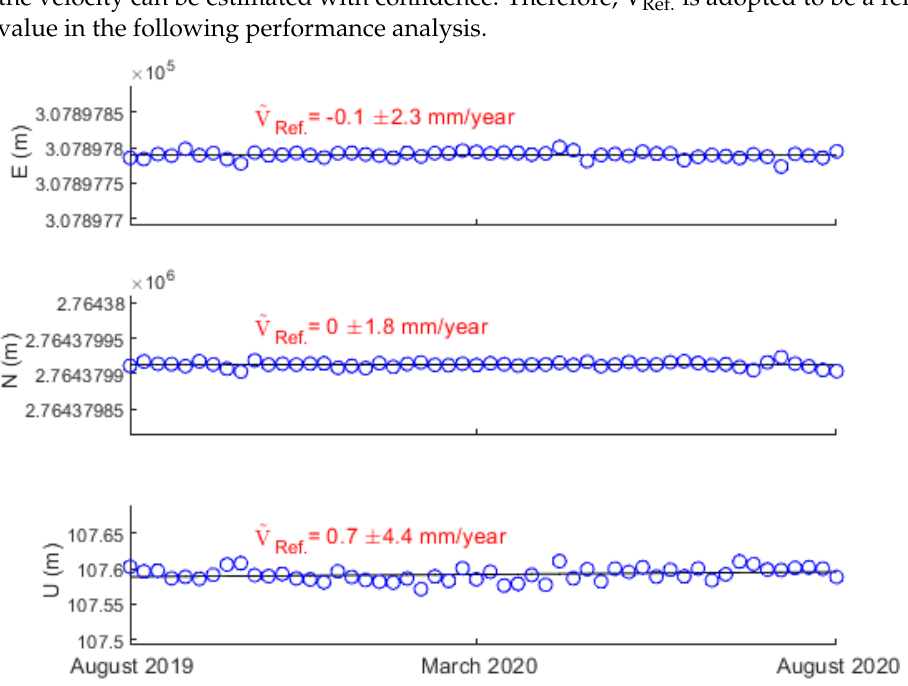
Figure 5. Estimated velocity and the standard deviation for 52 days. The top, middle and bottom panels refer to the E, N and U directions, respectively.